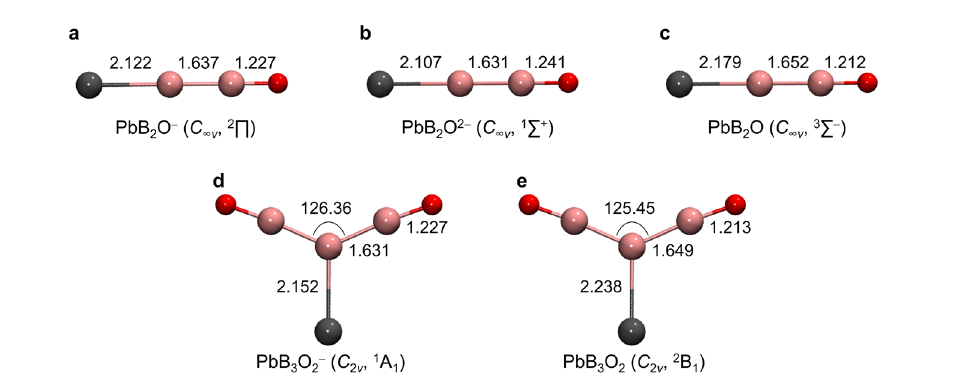
Fig. 3 Global minimum structures of PbB 2 O and PbB 3 O 2 at different charge states. a PbB 2 O – . b PbB 2 O 2 – . c PbB 2 O. d PbB 3 O 2 – . e PbB 3 O 2 . Bond lengths and bond angles are given in Å and degrees, respectively, at the CCSD/AVTZ level of theory. Cartesian coordinates of these structures are given in Supplementary Table